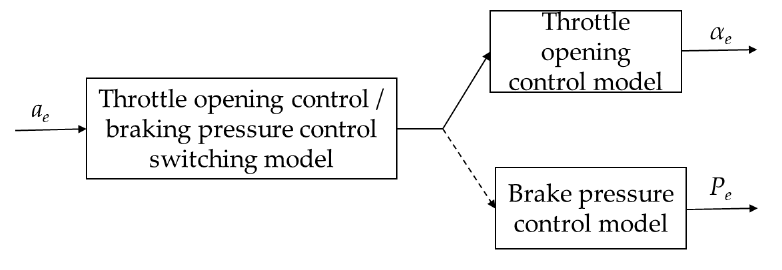
Figure 1. Simple inverse dynamics model.